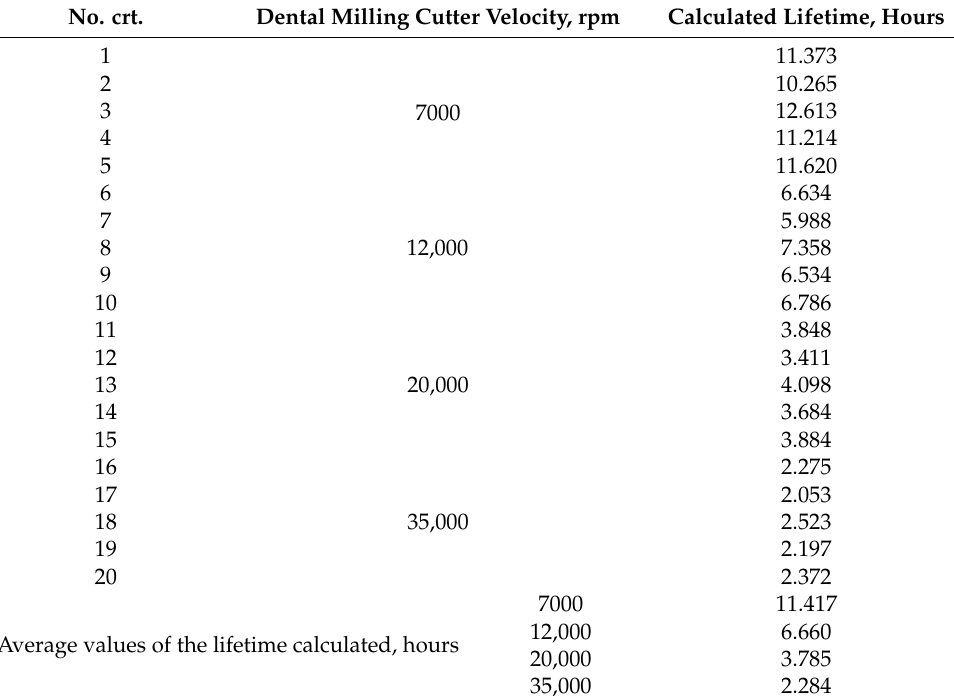
Table 4. The calculated lifetime of the active side of dental milling cutters used in experimental research. No.